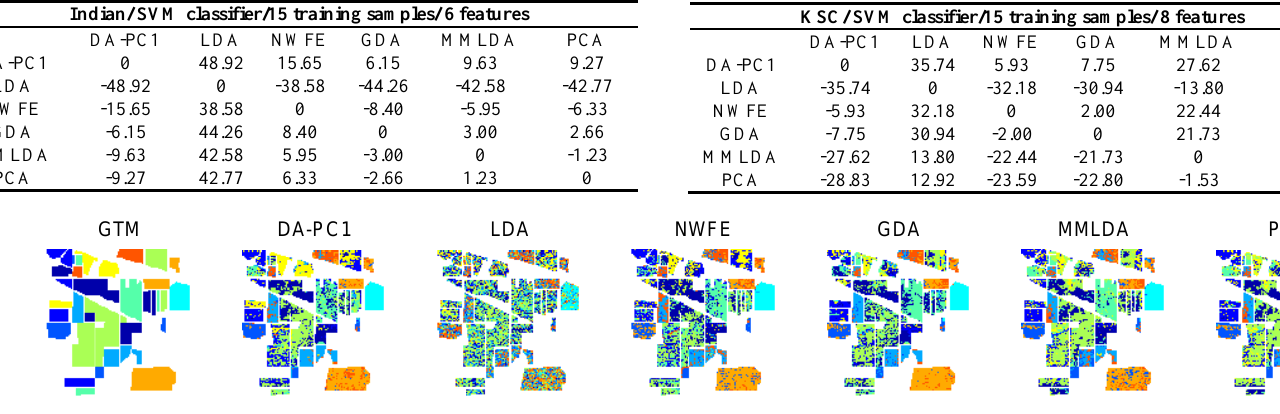
Figure 3. GTM and the classification maps of Indian dataset obtained by SVM classifier, 15 training samples and 6 extracted features.